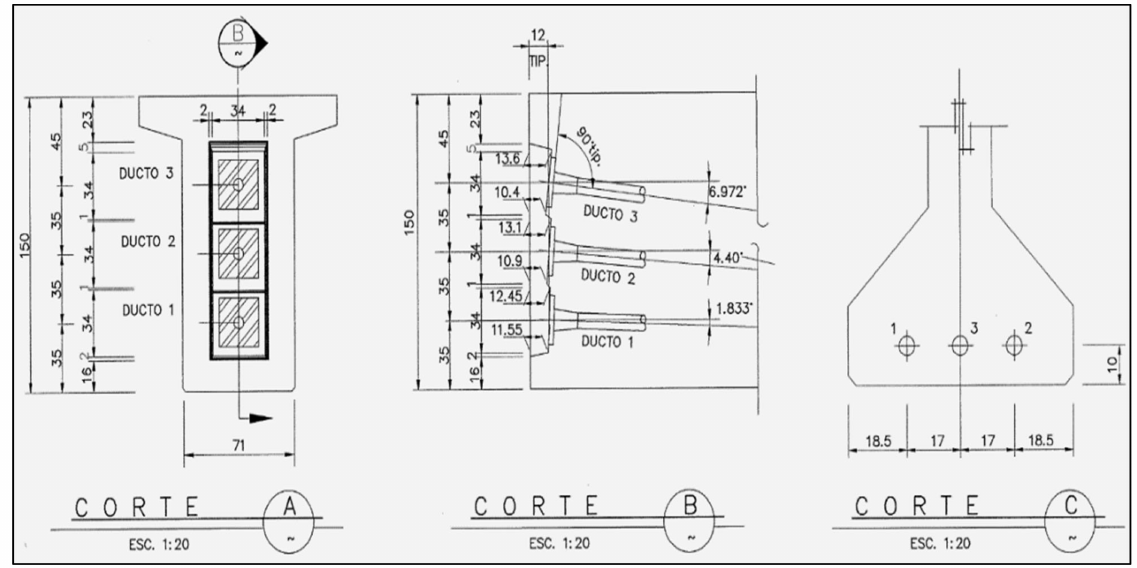
Figure 6. Original blueprint—pre-stressed girders on Guayac á n